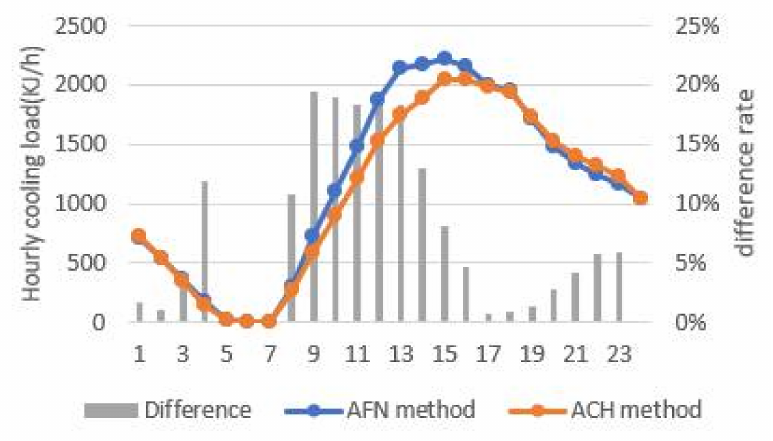
Figure 8. Comparison of the results of the AFN model and the ACH model for a cooling design day.